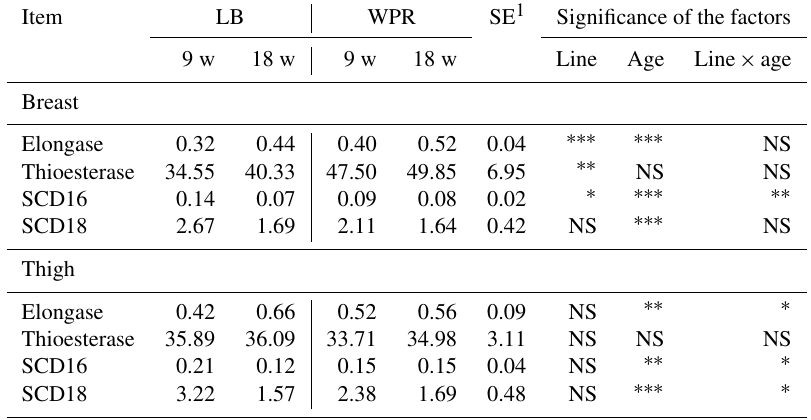
Table 4. Indices of lipid metabolism in the breast and thigh meat in La Belle (LB) and White Plymouth Rock (WPR) chickens according to the line and age. Item LB WPR SE 1 Significance of the factors 9 w Line Age Line × age Breast